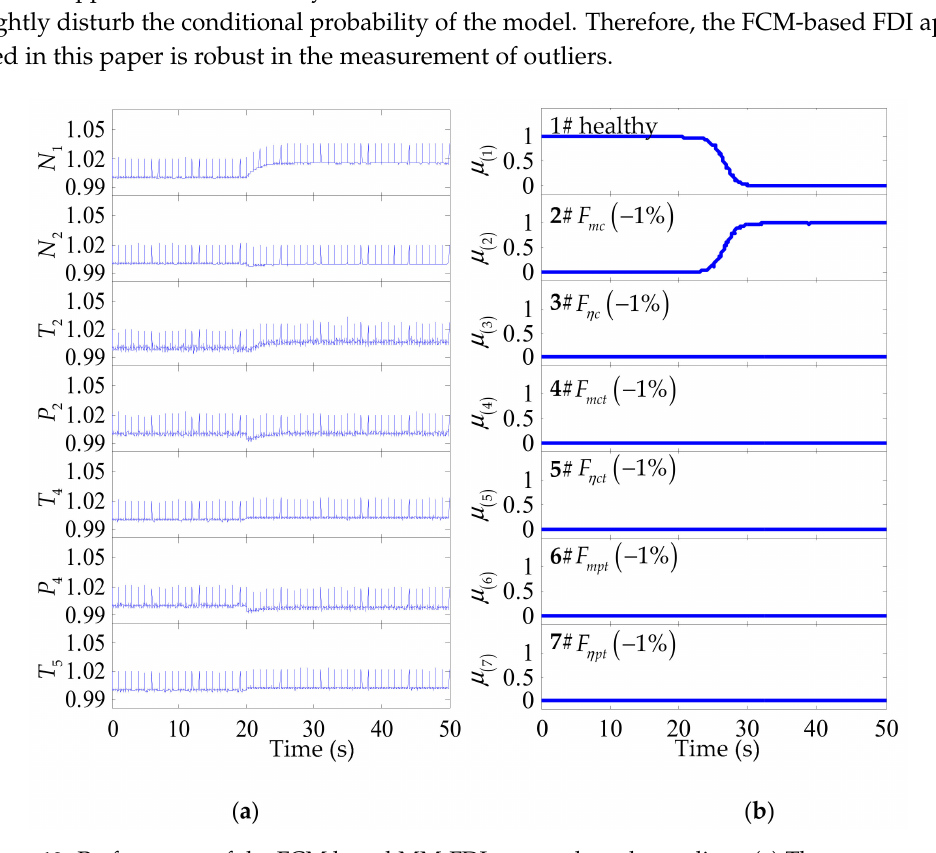
Figure 10. Performance of the FCM based MM-FDI approach under outliers. ( a ) The measurement parameters in the scenarios of F mc decreasing by 1% at t = 20 s; ( b ) The conditional probability µ i of each hypothetical model in the scenarios of F mc decreasing by 1% at t = 20 s along with